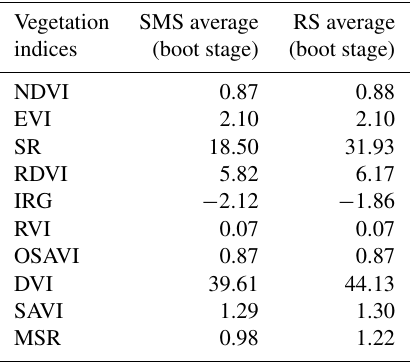
Figure 10. Same as Fig. 5, but for OSAVI.